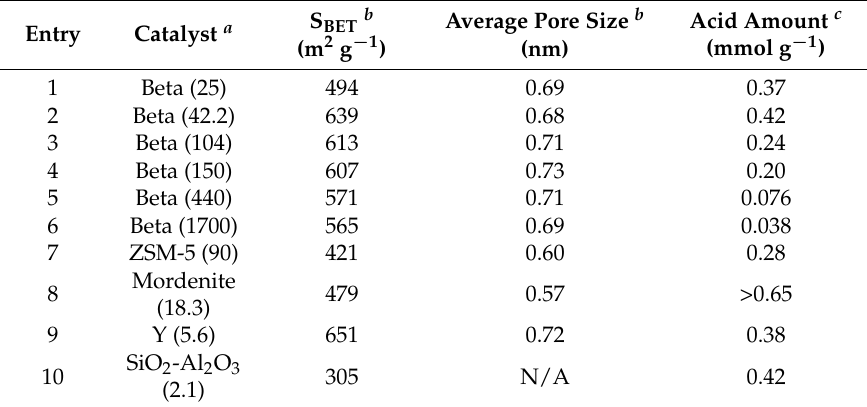
Table 1. Physicochemical properties of catalysts used.